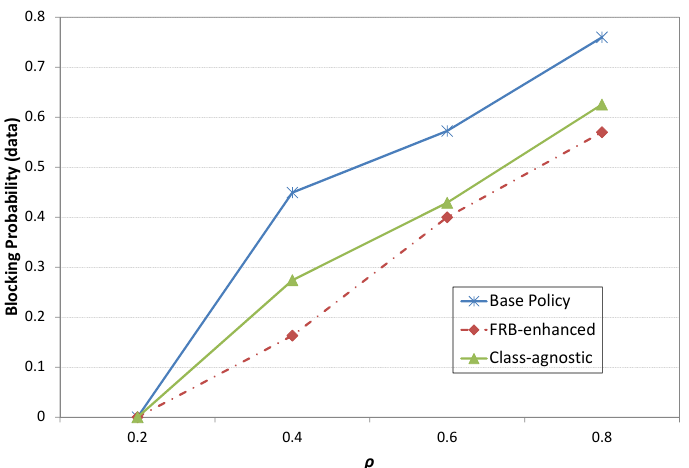
Figure 16. Class 3 (data) services blocking probabilities for the three scenarios.